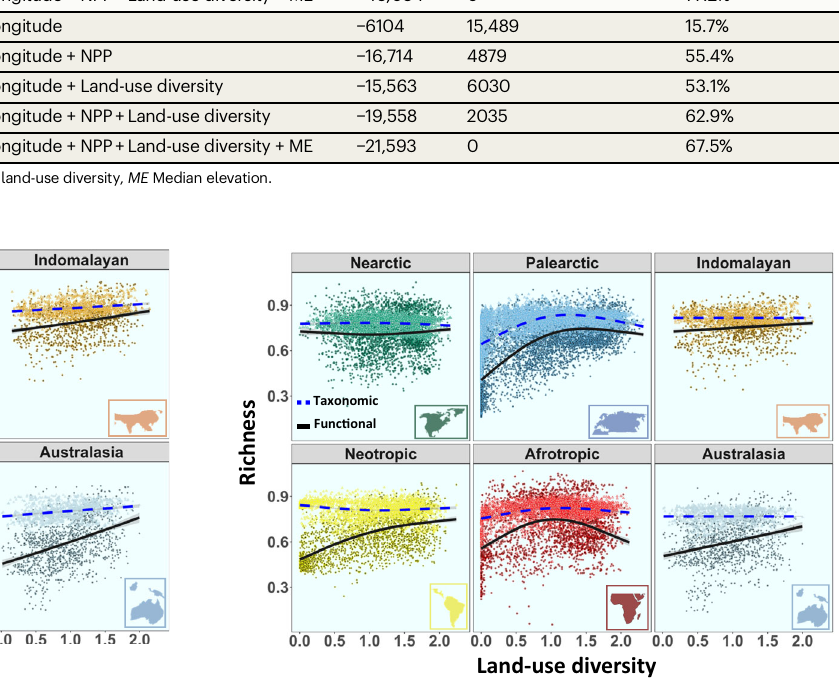
Fig.3|Effectofregionalland-usediversityonbirdrichnessafteraccountingfor primary productivity. Additive model fi t to partial residuals after accounting for primaryproductivity,showingtheassociationbetweenland-usediversity(Shannon index) and taxonomic richness (blue dashed line), and functional richness (black solid line) across the six main biogeographic realms. Each point represents a grid cell of one-degree size. Taxonomic and functional richness were standardized to themaximumvalueobserved.Linesshowthemodel fi tandshadowsrepresent95% con fi dence intervals. Nearctic: n =2630 grid cells. Neotropic: n =2262 grid cells. Palearctic: n =6123 grid cells. Afrotropic: n =2466 grid cells. Australasia: n =1212 gridcells.Indomalaya: n =1087gridcells.SourcedataareprovidedasaSourceData fi le. Biogeographic realm outlines were modi fi ed from